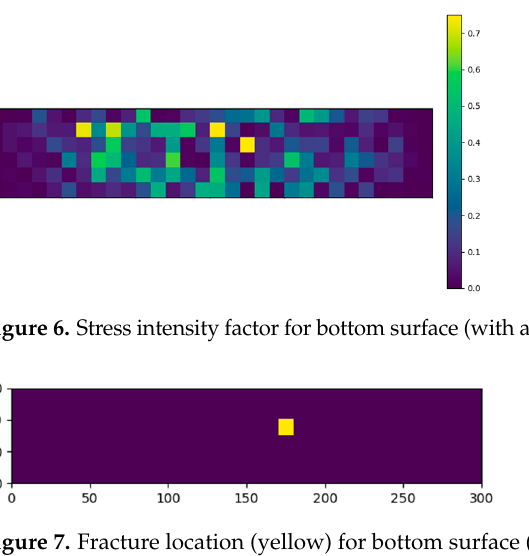
Figure 5. The 𝜎 (cid:3051) stress states of the top and bottom surfaces for a total load of ( a ) 1000 N and ( b ) 1800 N.